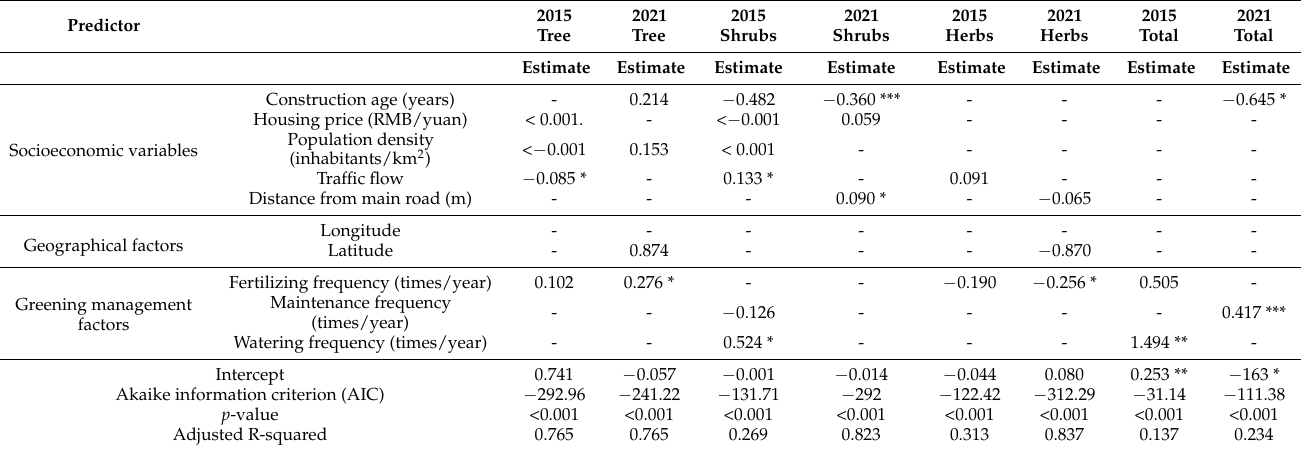
Table 4. Stepwise regression model with factors predicting the number of total, tree, shrub, and herbs species in 2015 and